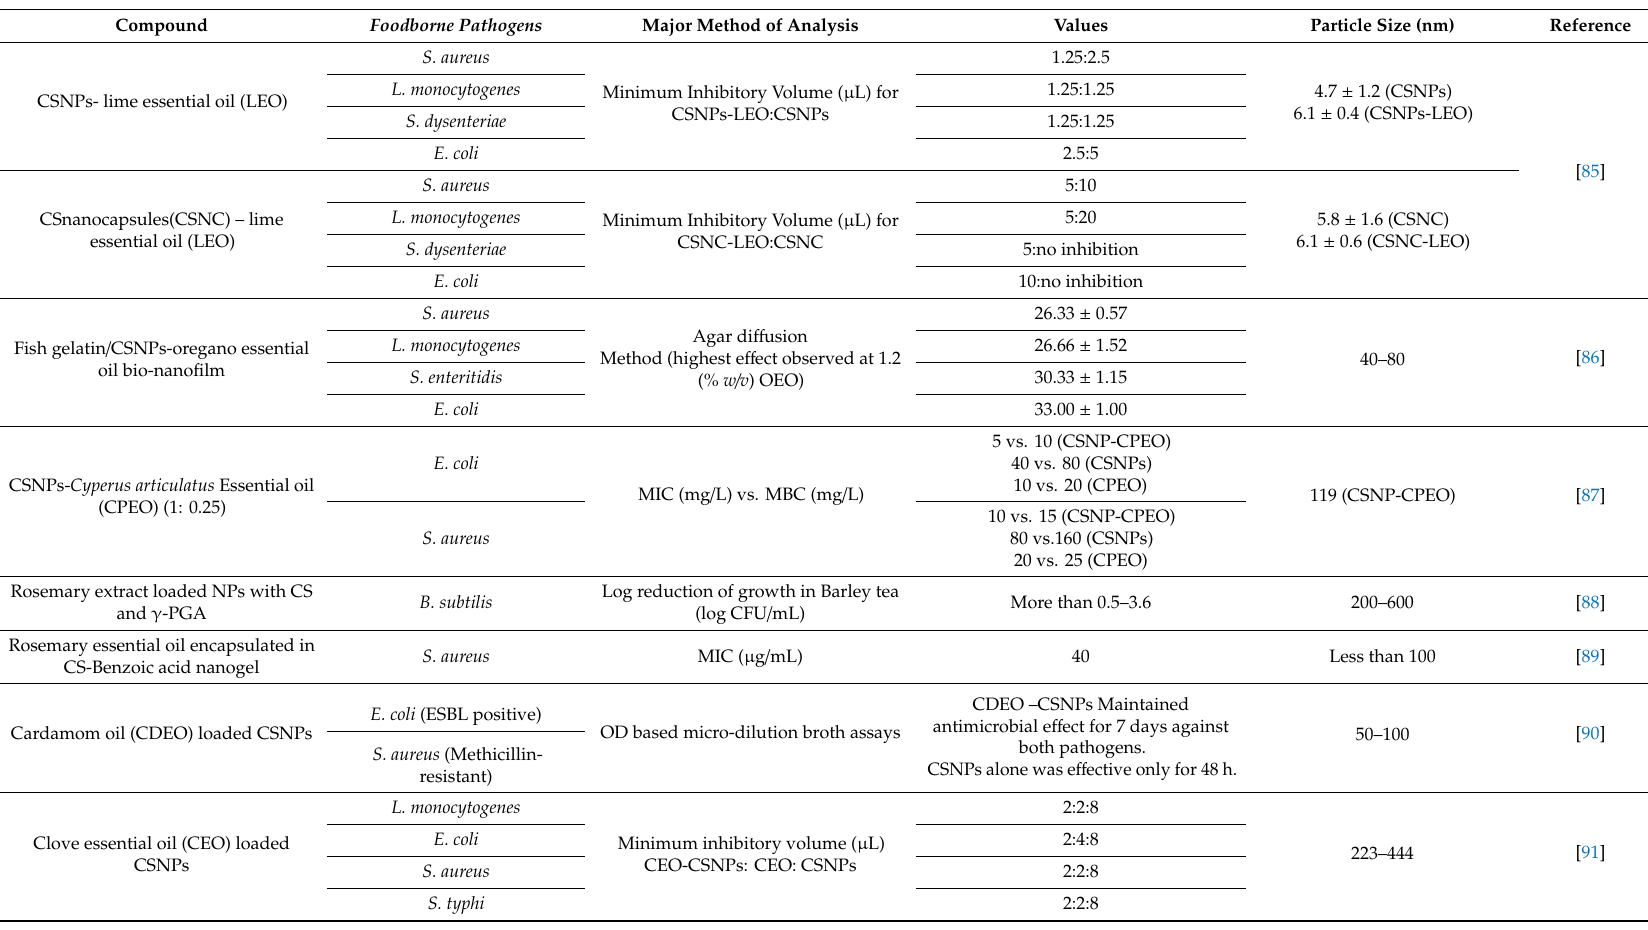
Table 3. Use of chitosan nanoparticles with plant essential oils against foodborne pathogens. (MIC: minimum inhibitory concentration, MBC: minimum bactericidal concentration).